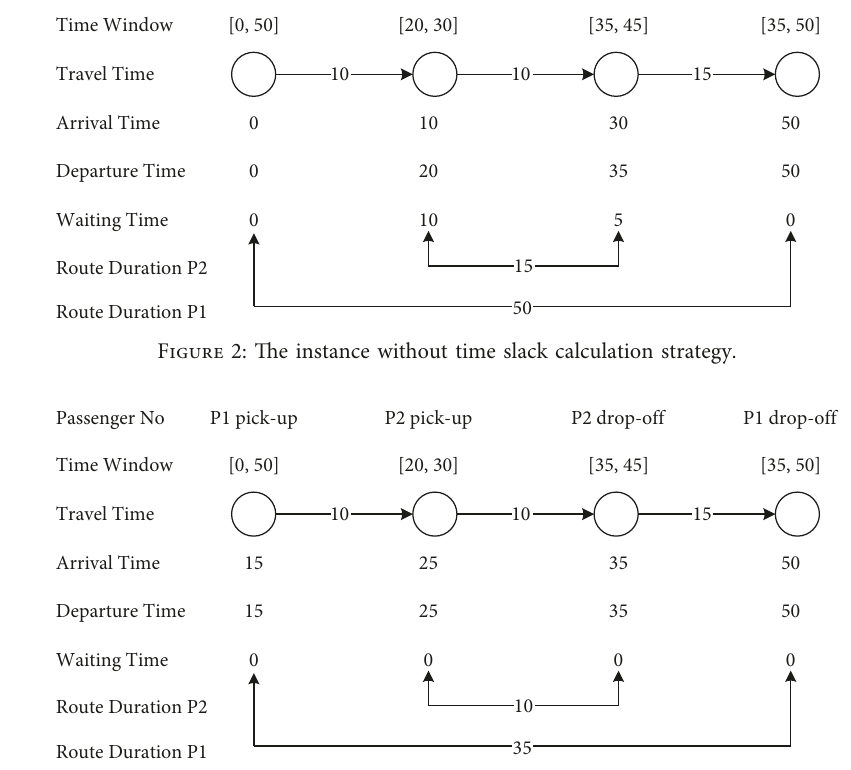
Figure 3: The instance with time slack calculation strategy. Table 3: Notations and definitions of symbols used in Section